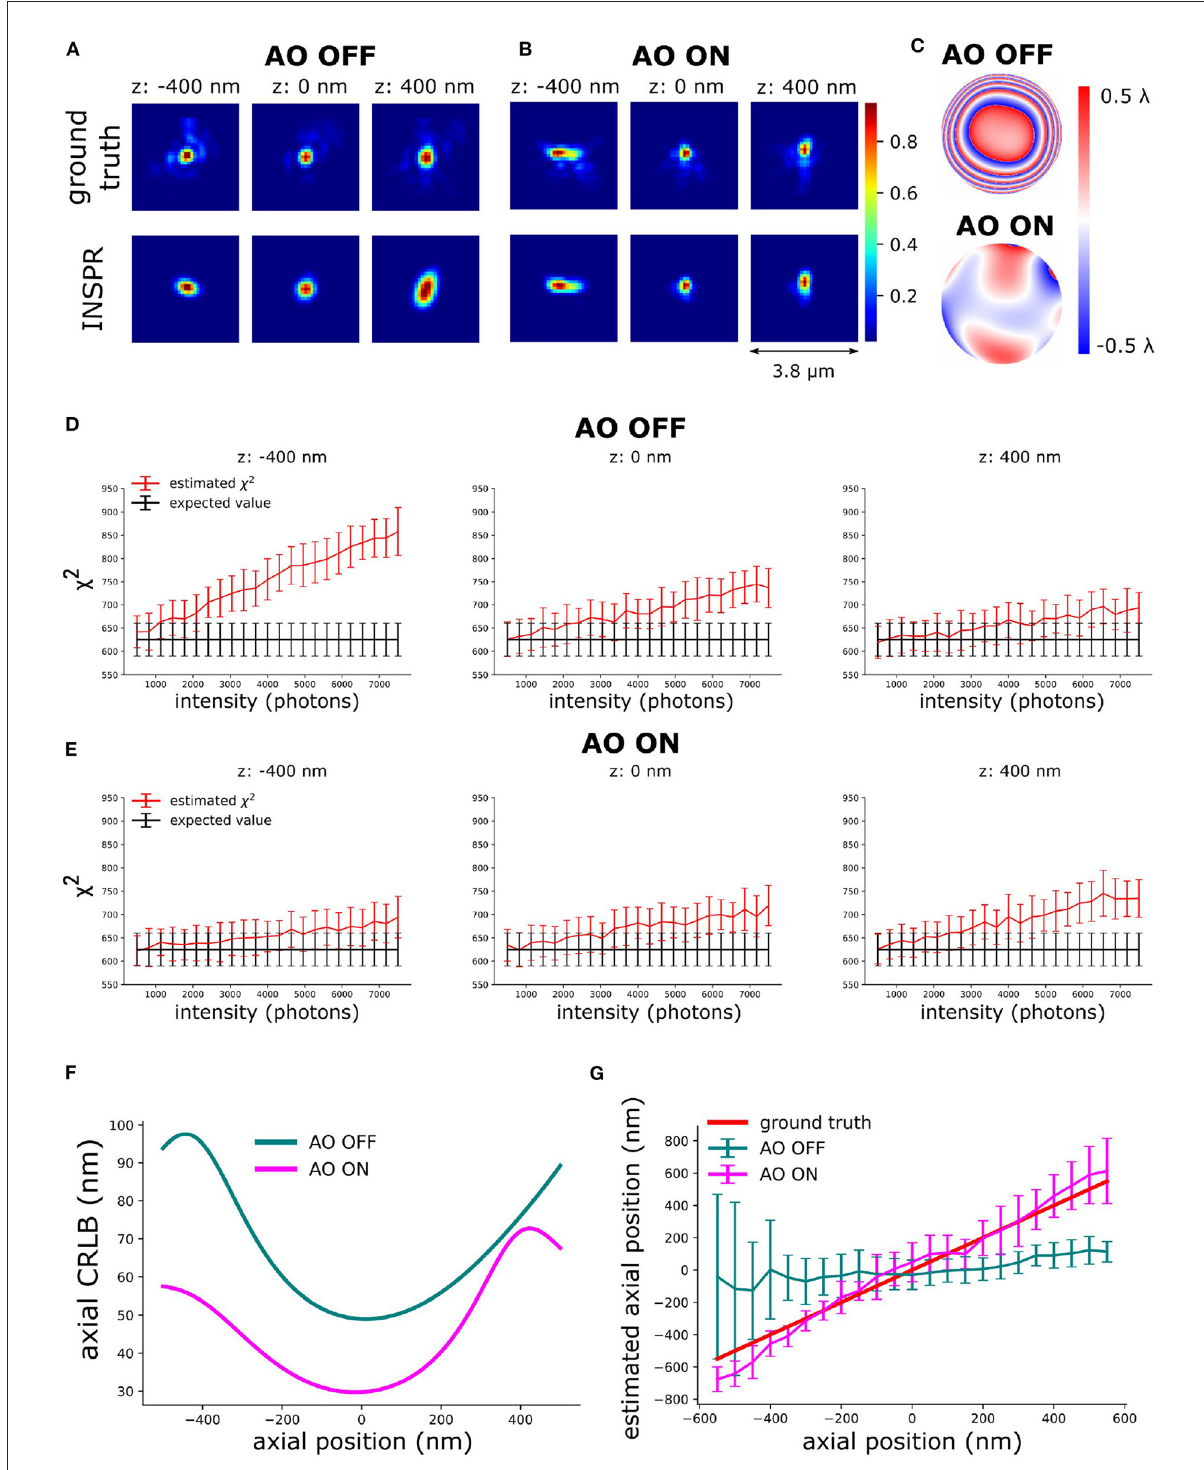
FIGURE4 Validation of the principle of AO-SOLEIL. (A) PSFs without AO correction. (B) PSFs with AO correction. (C) Pupil phase of ground truth PSF with addition 100 m λ astigmatism for 3D SMLM. (D) χ 2 value of AO OFF PSF at different intensity and depth (–400, 0, and 400 nm). In this test, we fixed the I/bg ratio to 33. (E) χ 2 value of AO ON PSF at different intensity and depth (–400, 0, and 400 nm). In this test, we fixed the I/bg ratio to 33. (F) Curve of axial CRLB vs. axial position (intensity: 1,000 photons, background: 30 photons/pixel). (G) Curve of axial position vs. estimated axial position. For each data point, we repeated the localization 51 times. The errorbar is the standard deviation of estimated axial